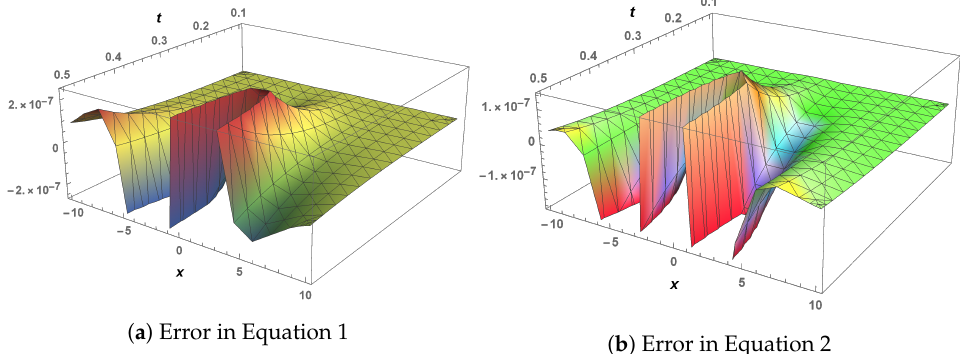
Figure 5. Three-dimensional (3D) errors analysis of Example 2 when β = 1 and η = a =